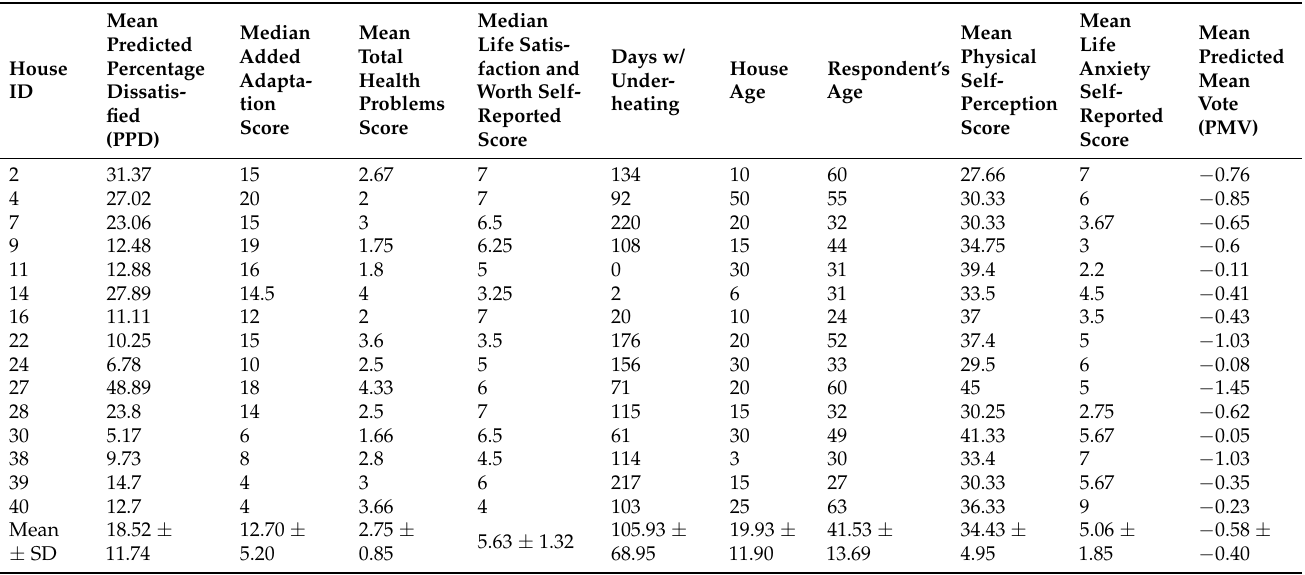
Table 11. Summary of survey results per house ID, for each of the variables used in multiple regression analyses.